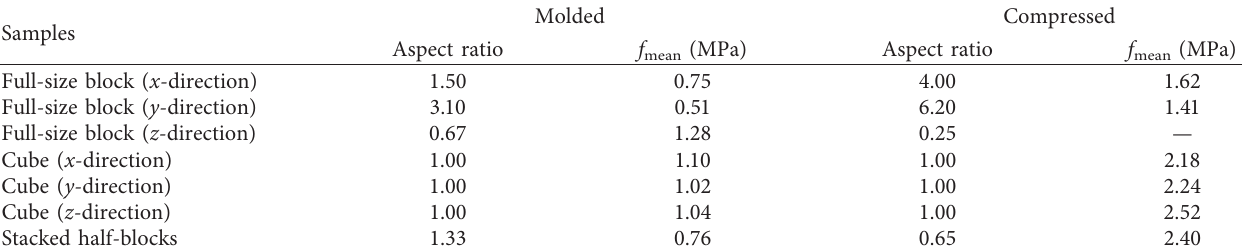
Table 8: Synthesis of the mean compressive strength measured on various samples.